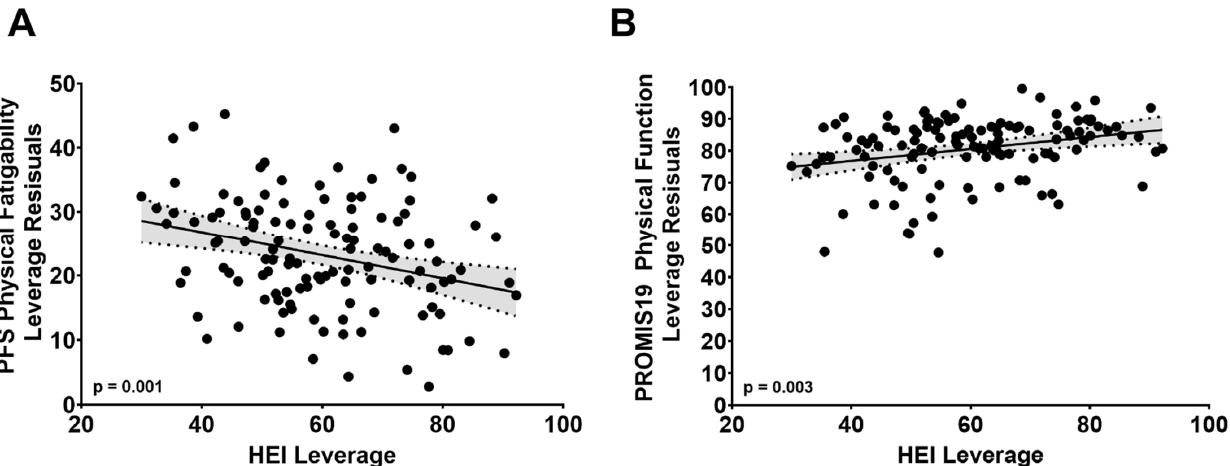
Figure 1. Leverage plots displaying the effect of the Healthy Eating Index (HEI) on Pittsburgh Fatigability Scale (PFS) Physical score ( A ) and PROMIS19 Physical Function ( B ) score after adjusting for age, sex, BMI, and the total number of medical conditions in a subset of 122 oldest ‐ old participants from the Geisinger Rural Aging Study.